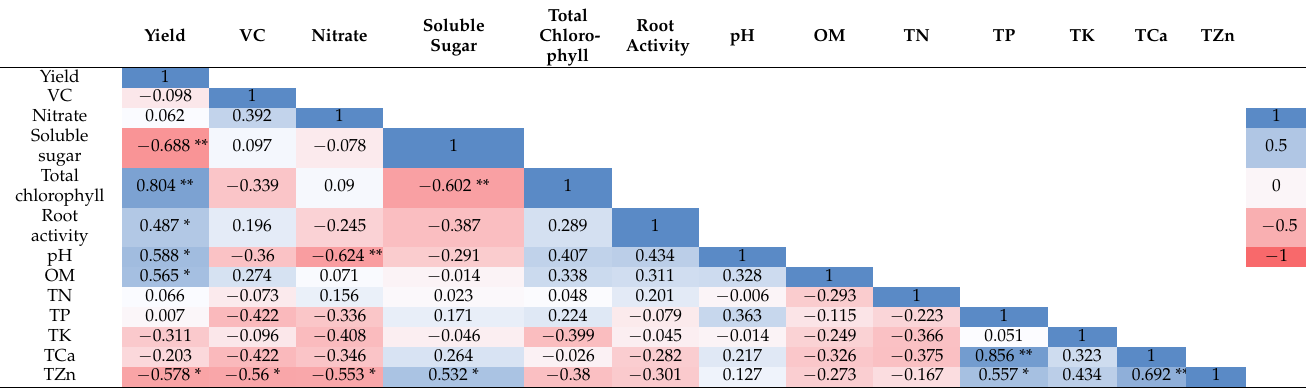
Table 4. Correlation with soil nutrients, yield, and quality of non-heading Chinese